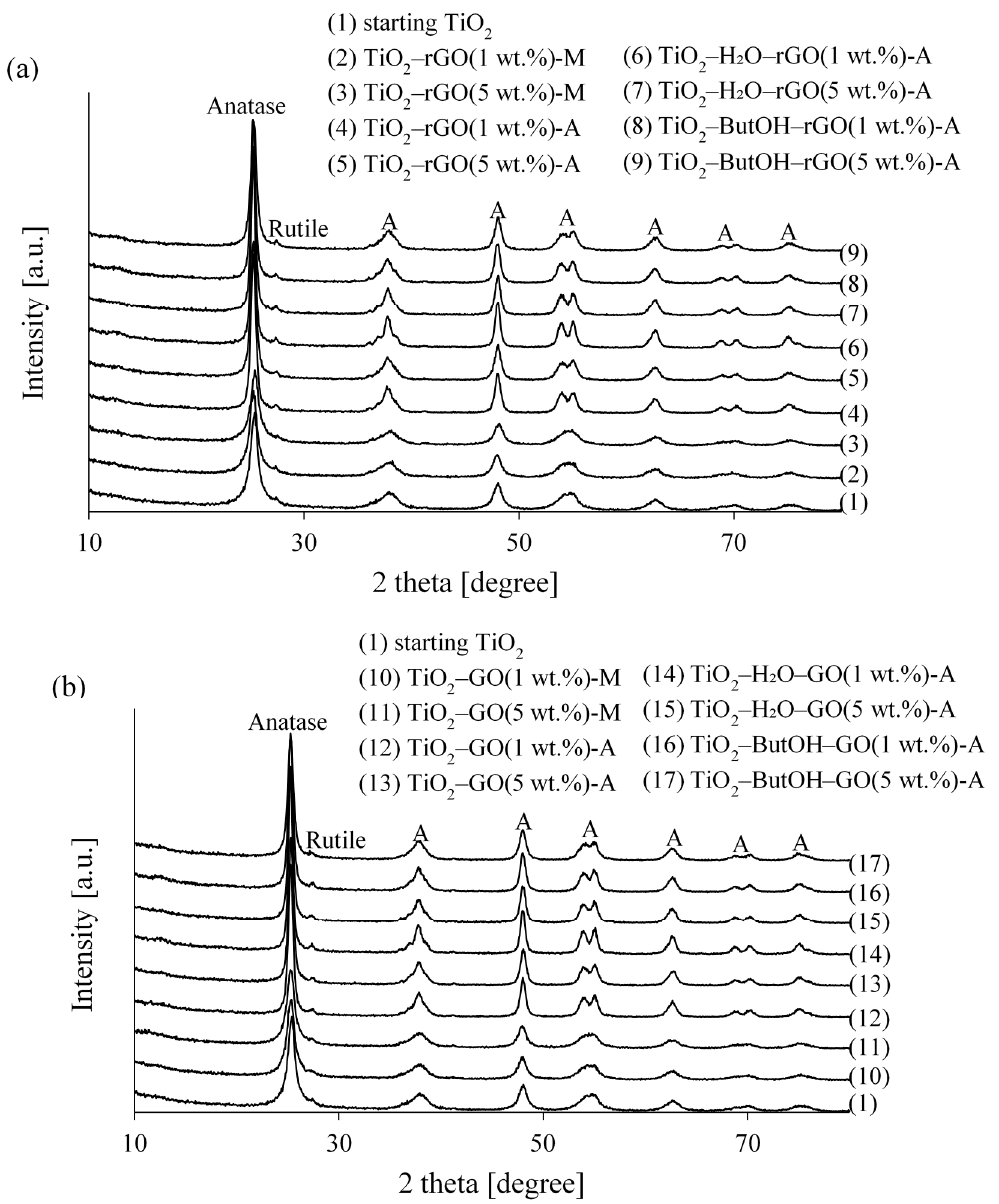
Figure 1. XRD patterns of ( a ) TiO 2 -rGO and ( b ) TiO 2 -GO hybrid nanocomposites.